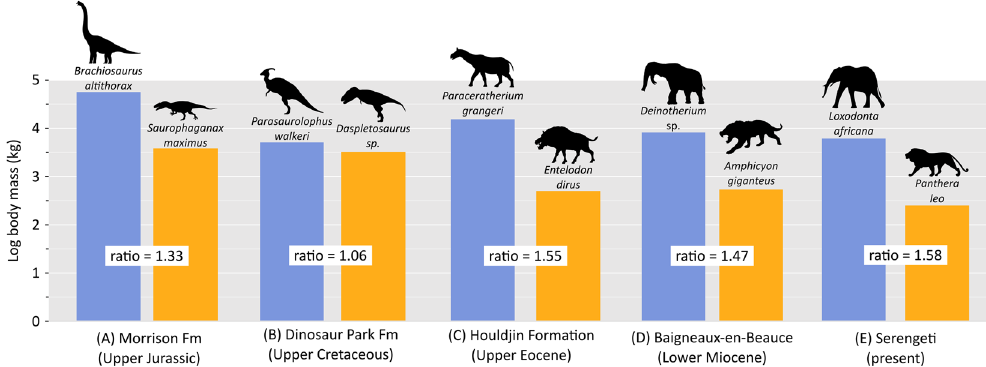
Figure 1. Ratios of log-transformed body mass of largest herbivore (in blue) to largest carnivore (in orange) for select fossil and modern ecosystems. Examples (A) and (B) illustrate dinosaur ecosystems; examples (C)–(E) illustrate mammal ecosystems. Note that herbivore:carnivore size ratios are closer to 1 in the dinosaur ecosystems; that is, predator and prey are more nearly equal in size. Silhouettes not to scale. Abbreviation: Fm, Formation.